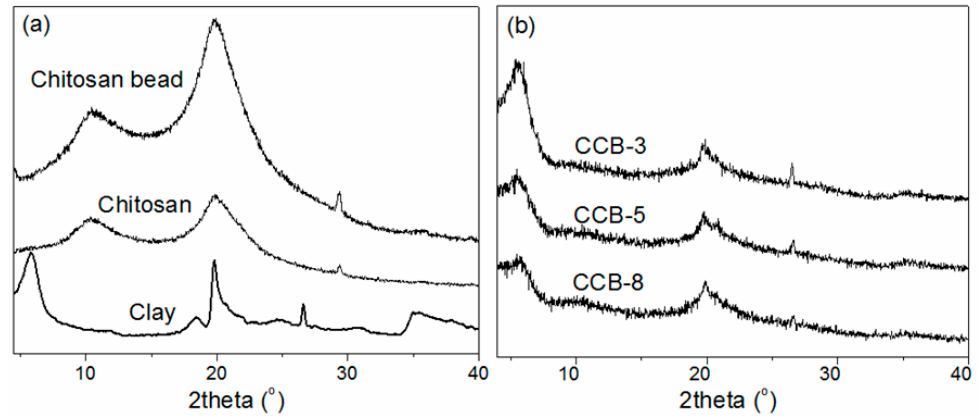
Figure 1. XRD patterns of various materials, chitosan, clay and chitosan bead ( a ); clay/chitosan composite materials ( b ).